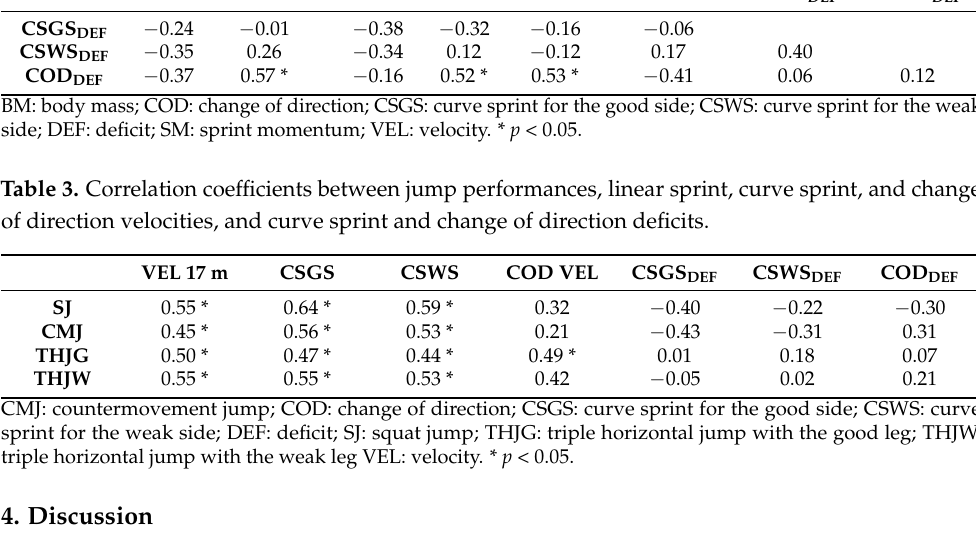
Table 2. Correlation coefficients between linear and curve sprint and change of direction velocities, body mass, sprint momentum, and curve sprint and change of direction deficits. BM VEL 17 m SM CSGS CSWS COD VEL CSGS DEF CSWS DEF CSGS DEF − 0.24 − 0.01 − 0.38 − 0.32 − 0.16 − 0.06 CSWS DEF − 0.35 0.26 − 0.34 0.12